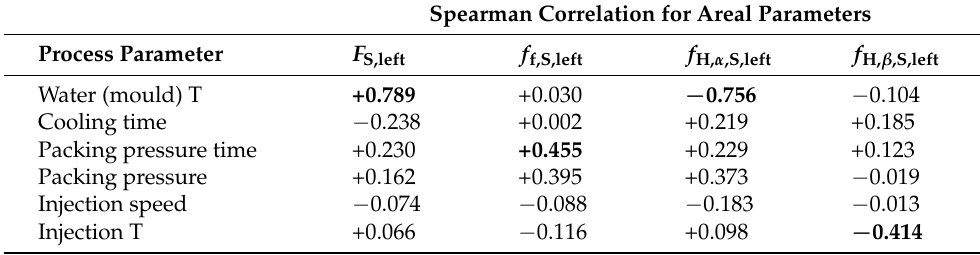
Table 6. Spearman correlation for the target areal parameters. Water (mould) temperature has a generally high impact on the quality parameter values.